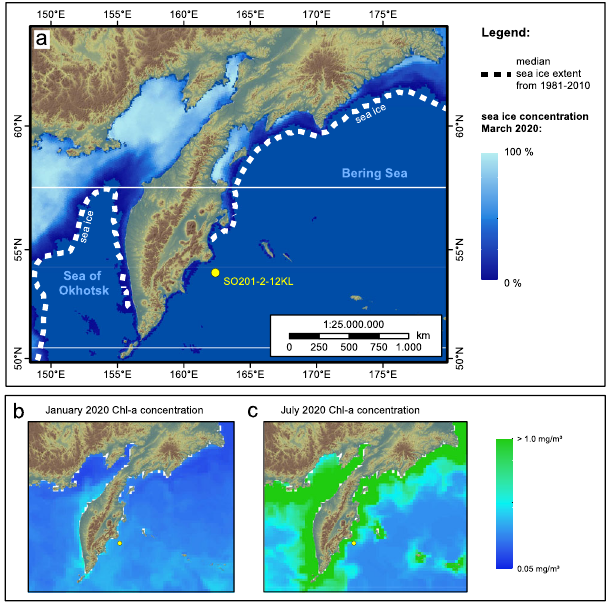
Fig.1|MapshowingthecoringsiteSO201-2-12KL(yellowdot)inthecontextof modern sea-ice and primary productivity. a The coring site (53.993°N, 162.37°E; waterdepth 2173m) islocated south ofthemodern sea-ice extent asshown by the medianforMarchbetween1981 – 2010 103 (dottedline)andthemeanmodernsea-ice concentration for March in 2020 104,105 (color scale from blue to white). b Modern seasonalpatternsofprimaryproductivityareindicatedbyalowmeanchlorophyll-a concentration in January compared to c highermean chlorophyll-a concentrations in July from 2020 (E.U. Copernicus Marine Service Information; https://resources.